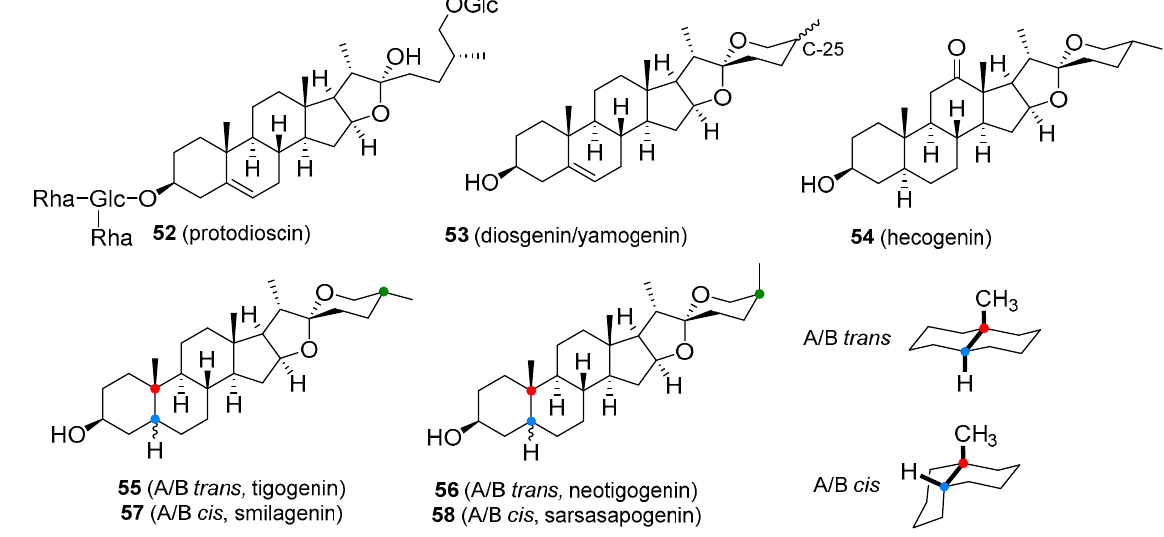
Figure 10. Plant-based steroids that are part of products marketed as testosterone boosters I.